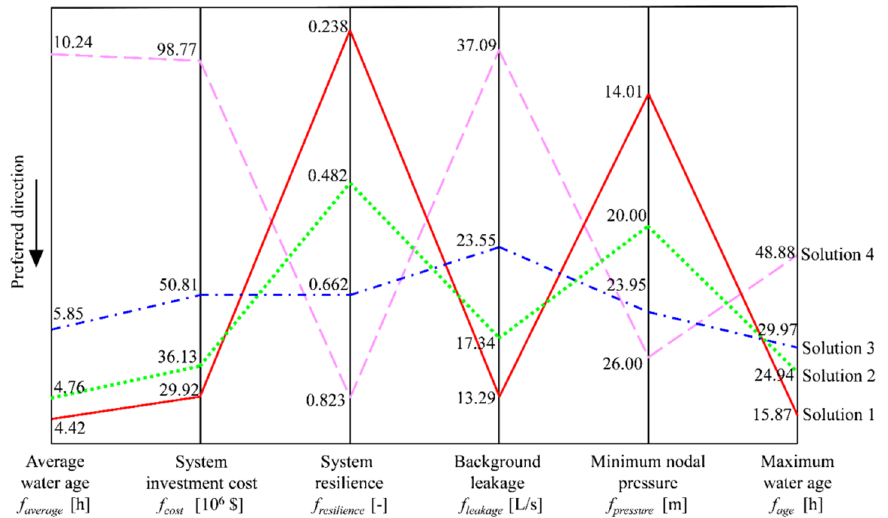
Figure 6. Parallel line plot for the four solutions (vertices of each line on the parallel axes representing the objective function values for a single solution, with arrows pointing in the direction of preference and the red, green, blue and purple lines represent solution 1, solution 2, solution 3 and solution 4, respectively).